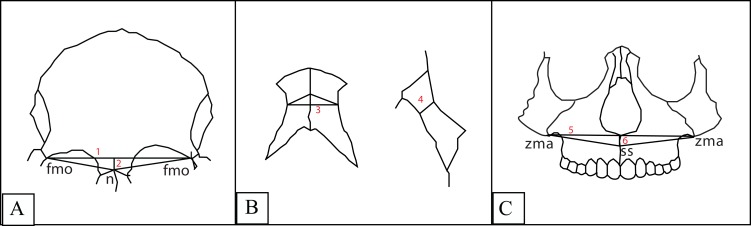
1. Frontal chord; 2. Frontal subtense; 3. Simotic chord; 4. Simotic subtense; 5. Zygomaxillary chord; 6. Zygomaxillary subtense.(A) Frontal index: denominator: the frontal chord between the frontomalaria orbitalia, numerator: the subtense of the nasion from the frontal chord. (B) Simotic index: denominator: the simotic chord (the minimum horizontal breadth of the nasal bone), numerator: simotic subtense (the minimum distance from the midian ridge of the nasal bone to the simotic chord). (C) Zygomaxillary index: denominator: the zygomaxillary chord between the zygomaxillaria anteriora, numerator: zygomaxillary subtense (distance from the subspinale to the zygomaxillary chord).